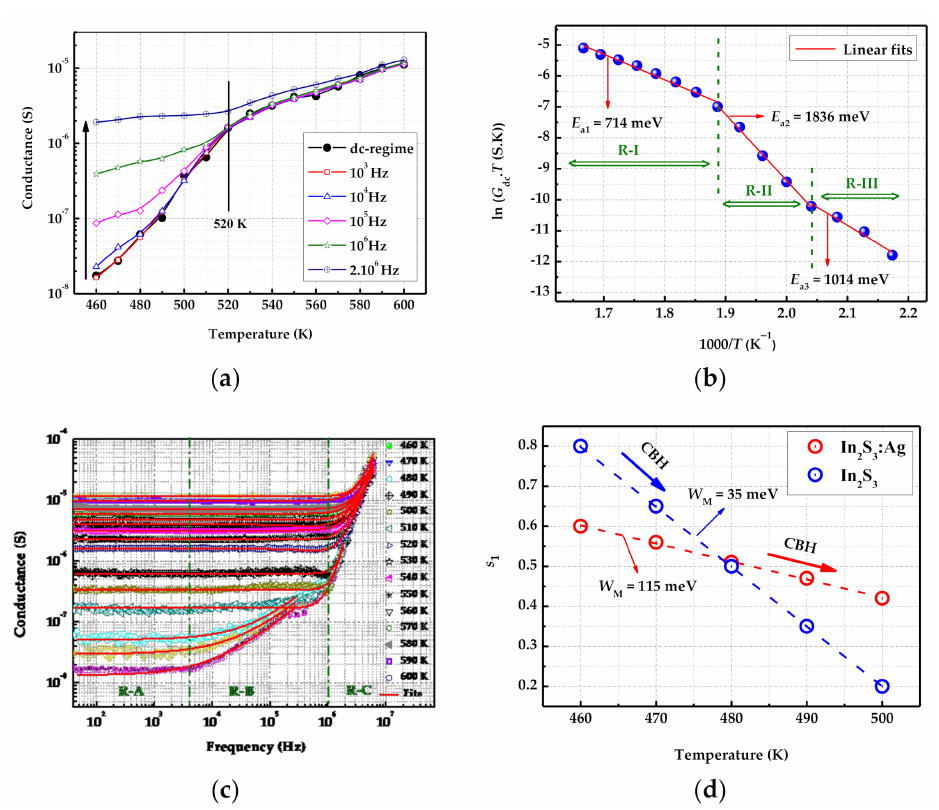
Figure 3. Electrical characteristics of thin film In 2 S 3 :Ag: ( a ) Temperature dependence of the direct current (dc) conductance and alternating current (ac) conductance at selected frequency values; ( b ) evolution of ln ( G dc T ) as a function of 1000/ T and the obtained activation energy values; ( c ) fre- quency dependence of the ac conductance, in the studied temperature range; ( d ) temperature dependence of exponent s 1 of the Bruce equation (the result for In 2 S 3 sample is also